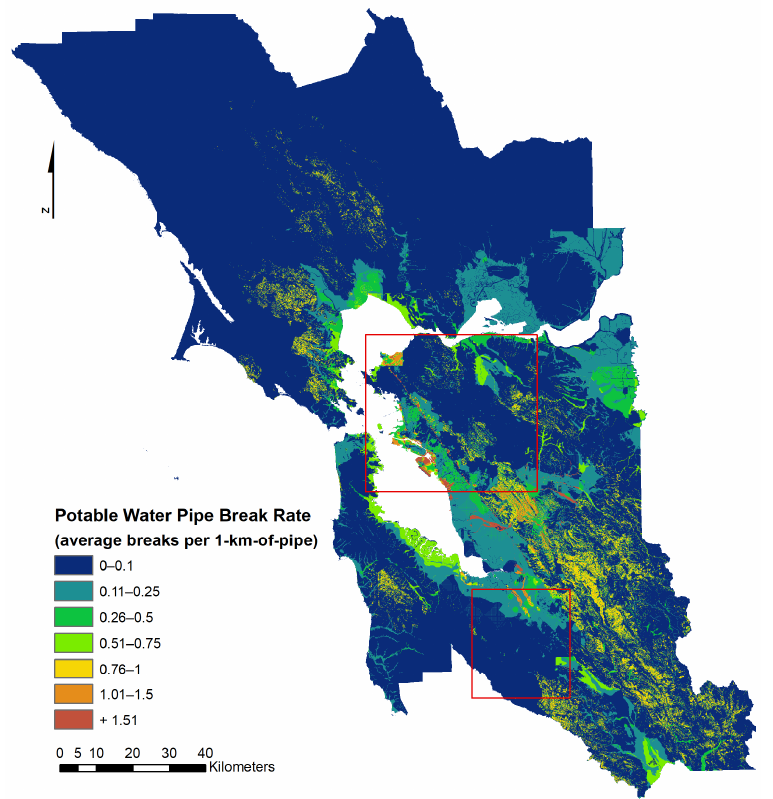
Figure 6. Merged average break rate per 1 km of pipe in the HayWired Scenario study region. Porter [1] study regions (red box): EBMUD (upper) and SJWC (lower).